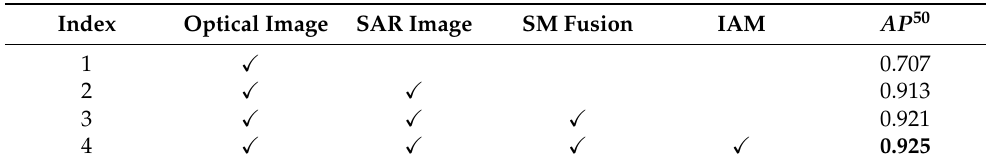
Table 3. Analysis of the residual SM module and IAM